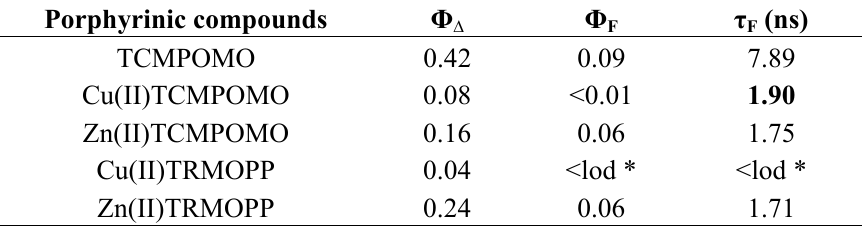
Table 3. Fluorescence emission quantum yields, singlet oxygen formation quantum yields and fluorescence lifetimes for the mesoporphyrinic compounds in chloroform.